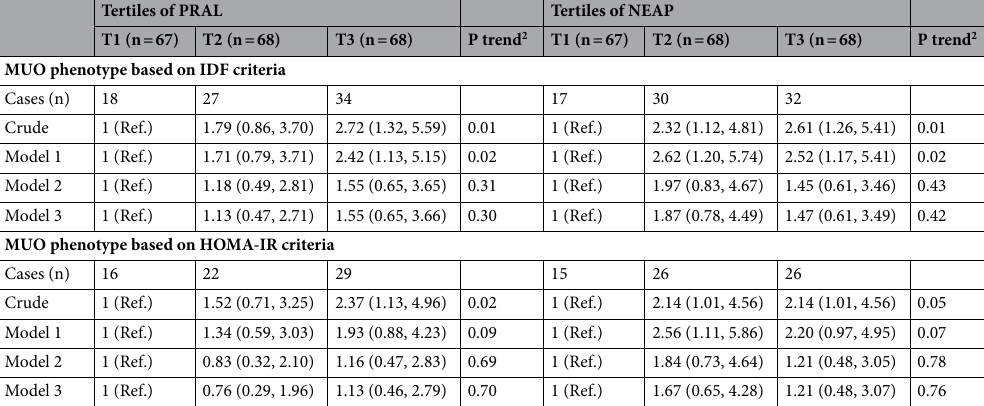
Table 3. Multivariate adjusted odds ratio (OR) and 95% confidence interval (CI) for MUO phenotype across tertiles of PRAL and NEAP 1 . 1 All values are odds ratios and 95% confidence intervals. Model 1: Adjusted for age, sex, and energy intake. Model 2: Additionally, adjusted for physical activity and socioeconomic status (evaluated based on parental education level, parental job, number of family members, having car in the family, having computer/laptop, having personal room and having travel by using demographic questionnaire). Model 3: Additionally, adjusted for BMI. 2 Obtained by the use of tertiles of PRAL or NEAP as an ordinal variable in the model.